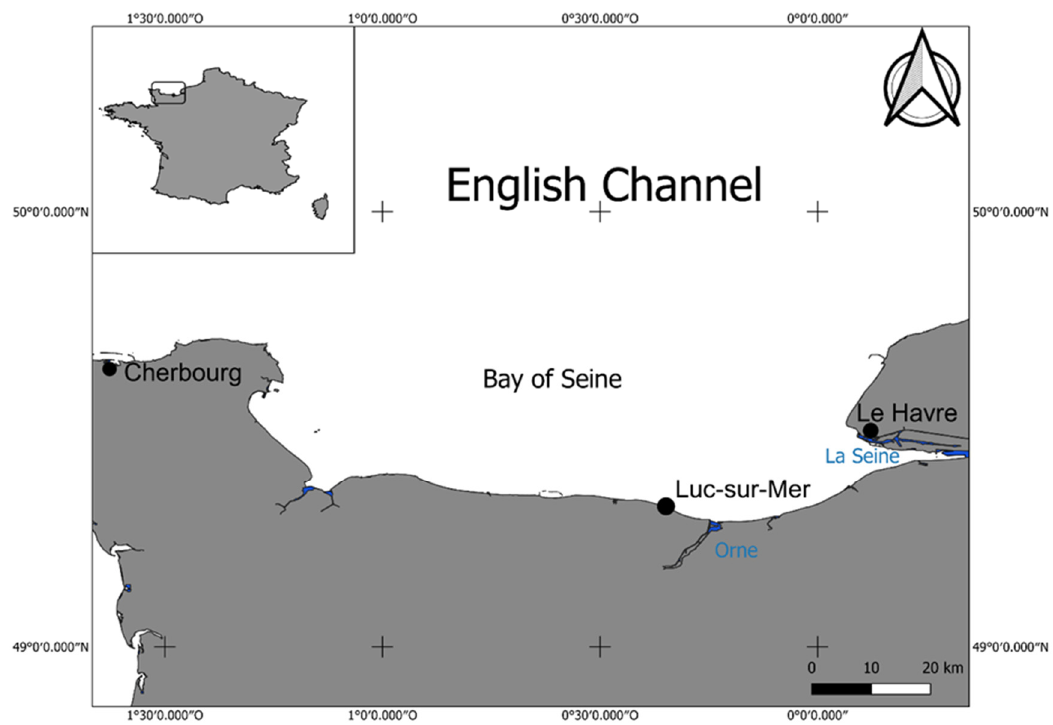
Figure 1. Location of the experimental site on the intertidal zone of Luc-sur-Mer (Calvados coast, southern part of the Bay of Seine).